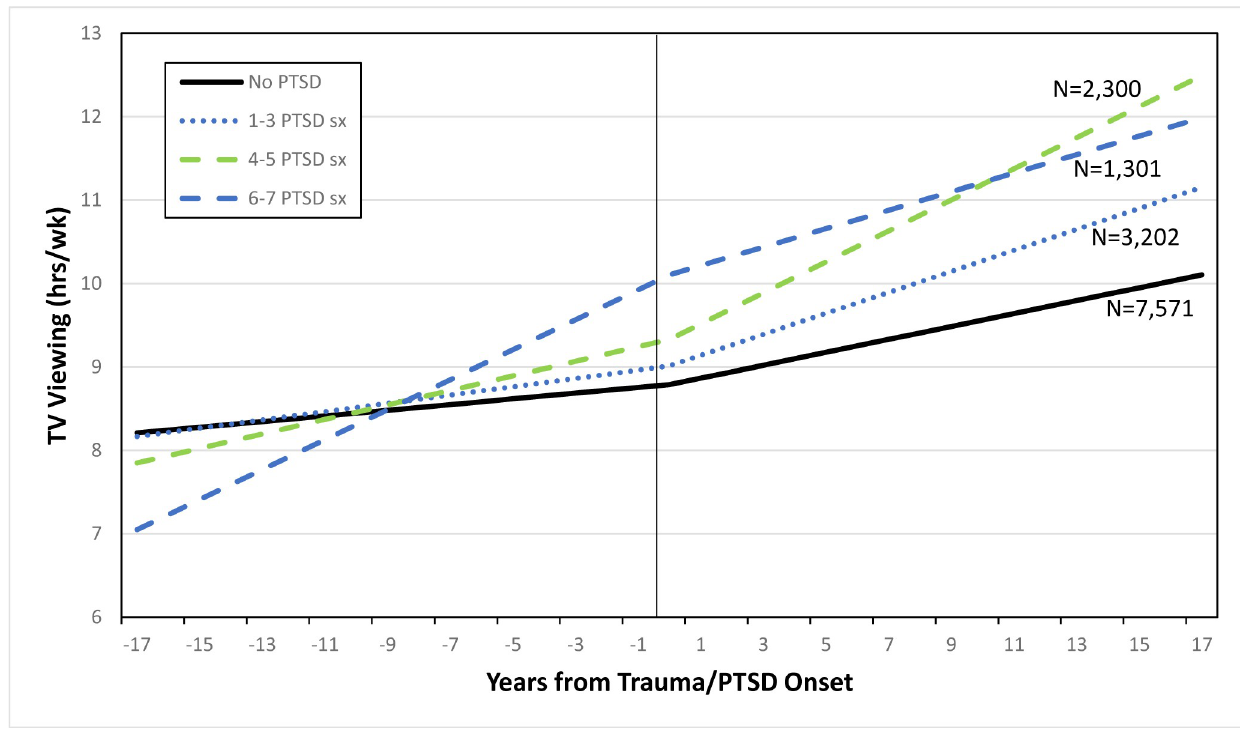
Fig 3. Age-adjusted predicted television viewing trajectory over time by trauma/PTSD group, before and after trauma/PTSD onset, among subsample. (n = 14, 374). Notes: Includes women with trauma/PTSD onset during follow-up, between 1991–2009 (n = 14, 374). Zero marks the year of trauma/PTSD onset. PTSD characterized in association with worst